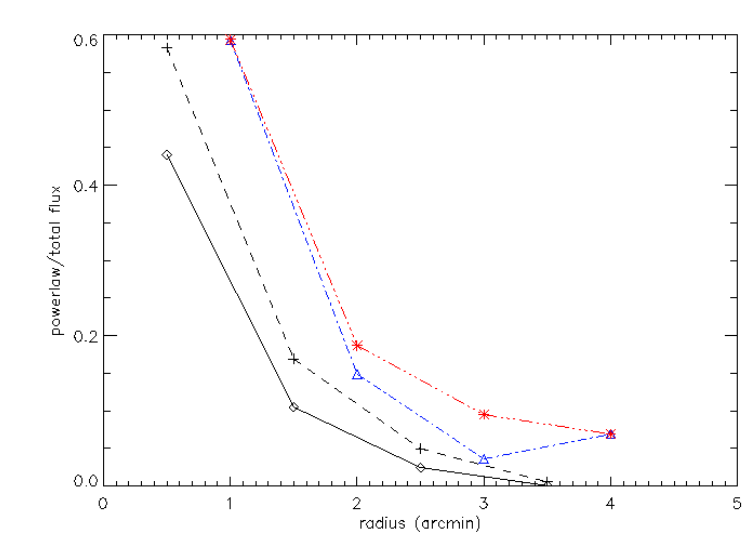
Figure 5. Fractional powerlaw flux as a function of average radius of annular region for XRT- NuSTAR combined fit for 3 November 2015 data (marked by diamonds and connected with black continuous line), only NuSTAR data for 3 November 2015 (marked by plus sign and connected with dashed black line), only NuSTAR data for 1 February 2017 (marked by triangle and connected with dash-dotted blue line) and only NuSTAR data for 4 February 2017 (marked by asterisk and connected by dash-three dotted red line).